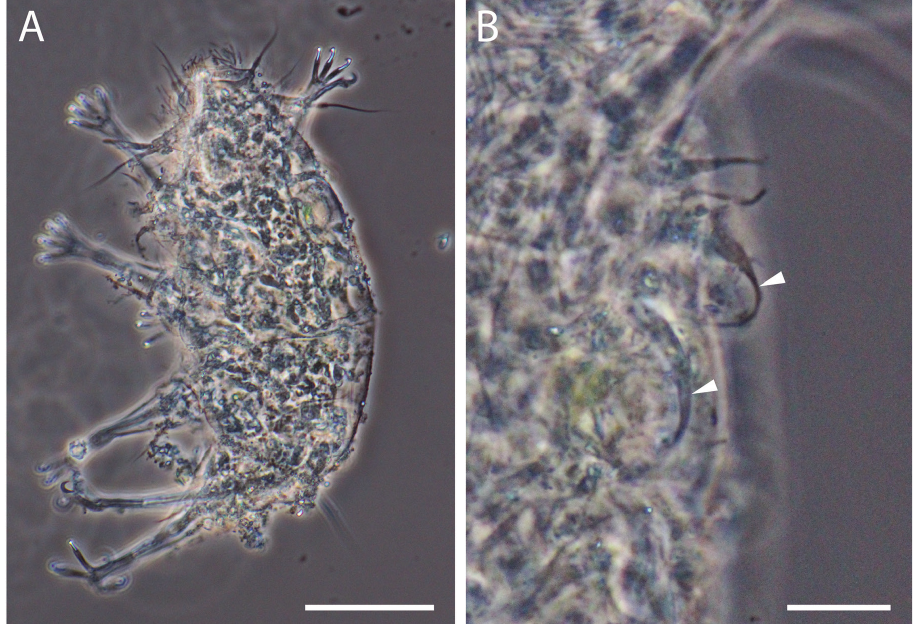
Figure 7. Phase contrast micrograph of Halechiniscus yanakaagii sp. n., holotype KUZ Z712. A dorso- lateral view, scale bar = 50 μm B double processes (white arrowhead), scale bar = 10